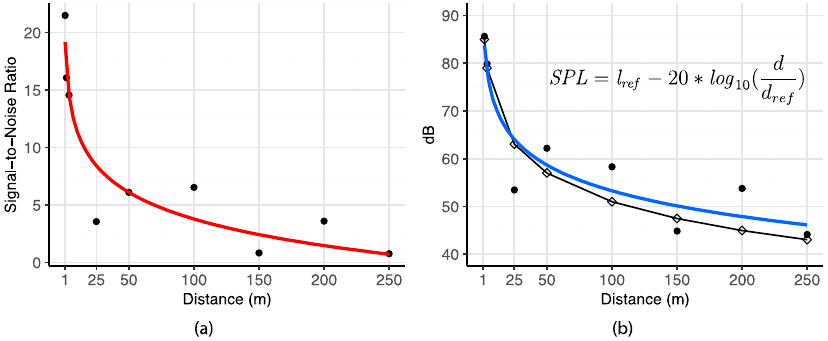
Figure 3. Attenuation of bird vocalization detectability over distance from sensor. Plot ( a ) is the measured signal-to-noise ratio (SNR). Plot ( b ) shows the measured sound pressure level (blue line fitted by logarithmic curve) versus theoretical attenuation (equation provided) of a 91 dB sound (black line) by spherical spreading.